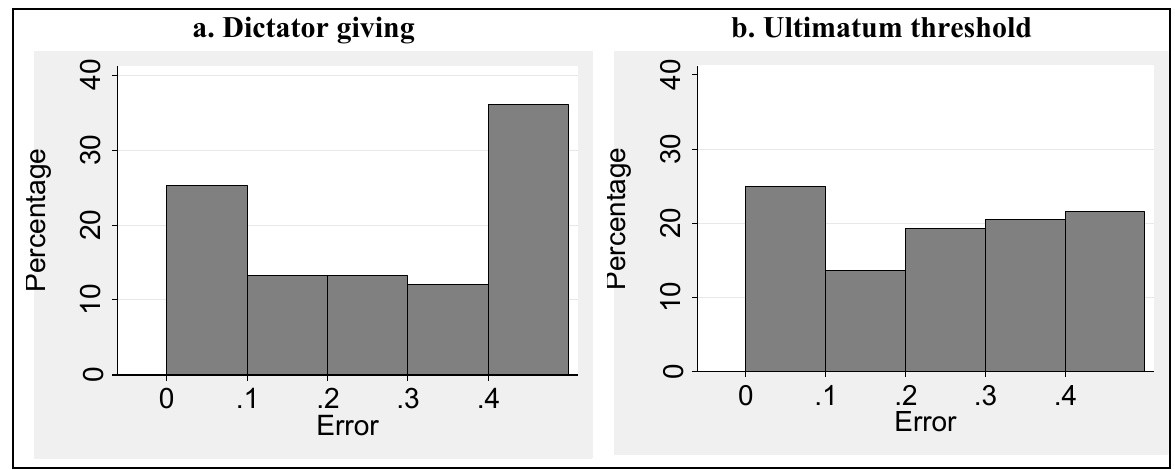
Figure A.4. Prediction